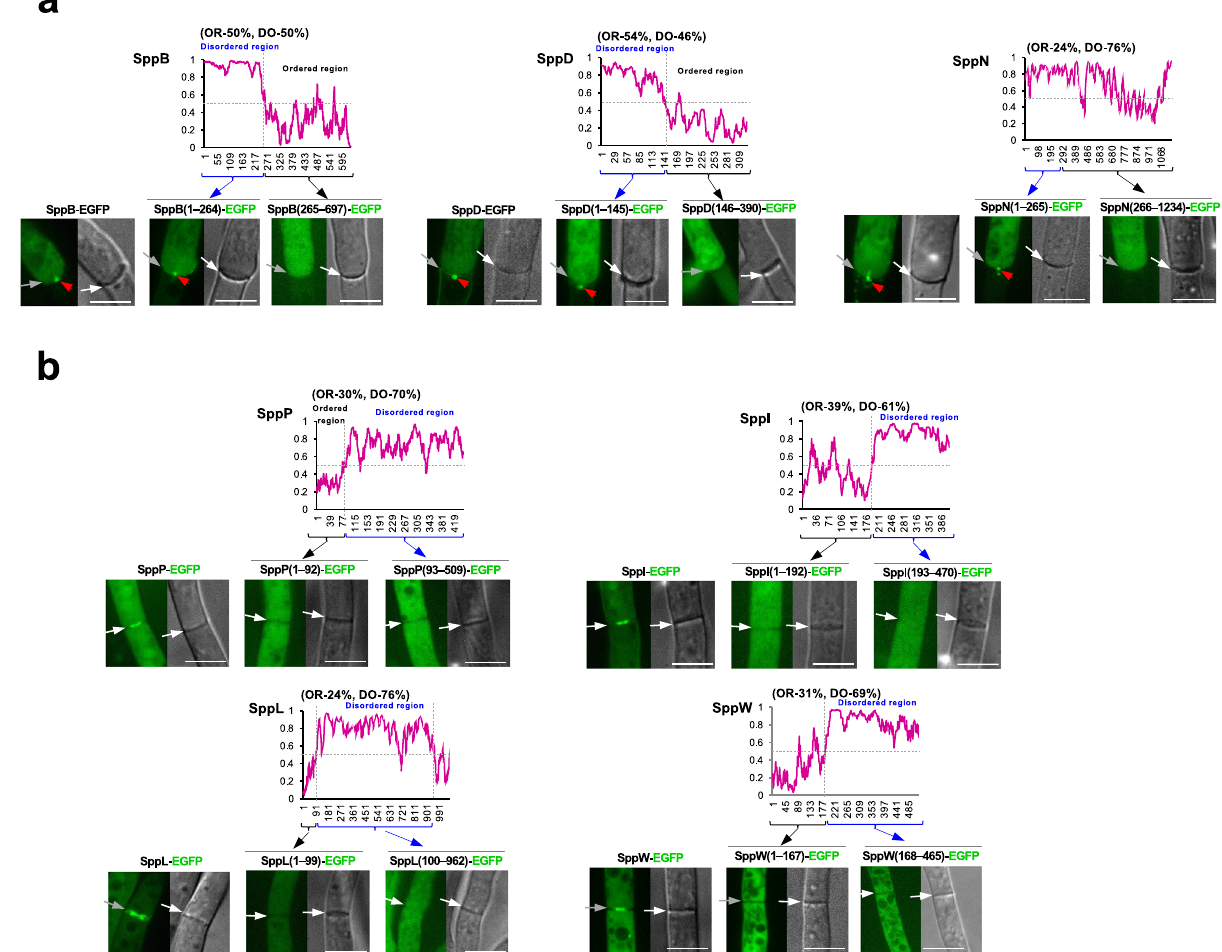
Fig. 6 | Prediction of disordered regions and analysis of truncated SPP protein variantlocalization.a ThreeSPPproteinsshowingseptalporeaccumulationupon hyphalwoundingharbored aconsiderablelengthofadisorderedregionseparated from the ordered region. b Four SPPproteins localizedaround the septalporeand harbored a considerable length of the disordered region separated from the orderedregion.GraphsshowthepredictionofdisorderedregionsusingIUPred2A; the Y axis indicatesthe predicted probability ofdisorder, and the X axis represents